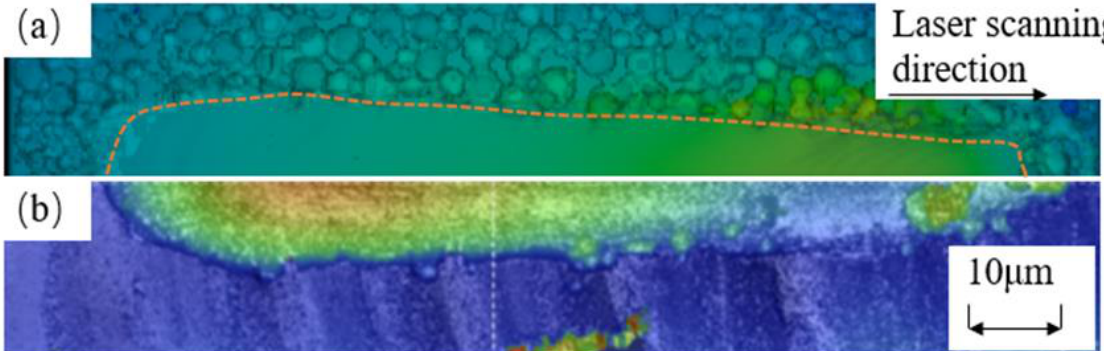
Figure 7. Track morphology comparison. ( a ) The simulated track morphology, obtained at 195 W, 0.4 m/s and 0.05 mm; ( b ) Experimental track morphology, obtained at 195 W, 0.4 m/s and 0.05 mm (power, speed and spot diameter). Reprinted with permission from [37]. Copyright 2021 The Society of Manufacturing Engineers.